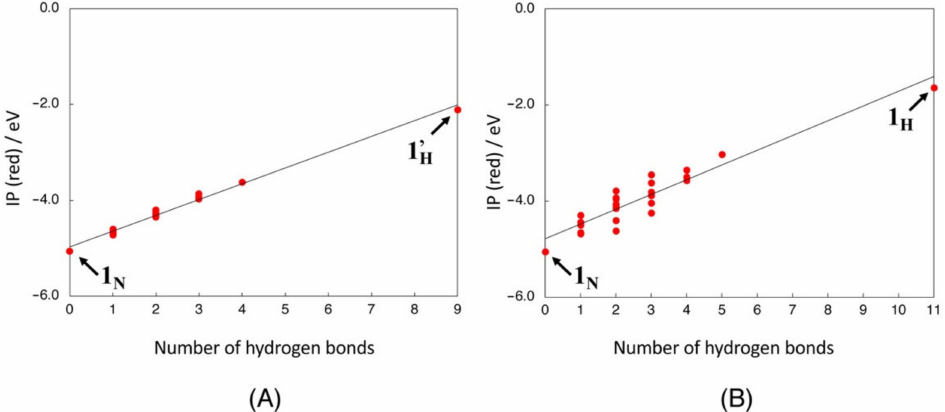
Figure 3. The relationships between the number of hydrogen bonds and calculated IP(red) values. ( A ) The peptide models. ( B ) The amino acid